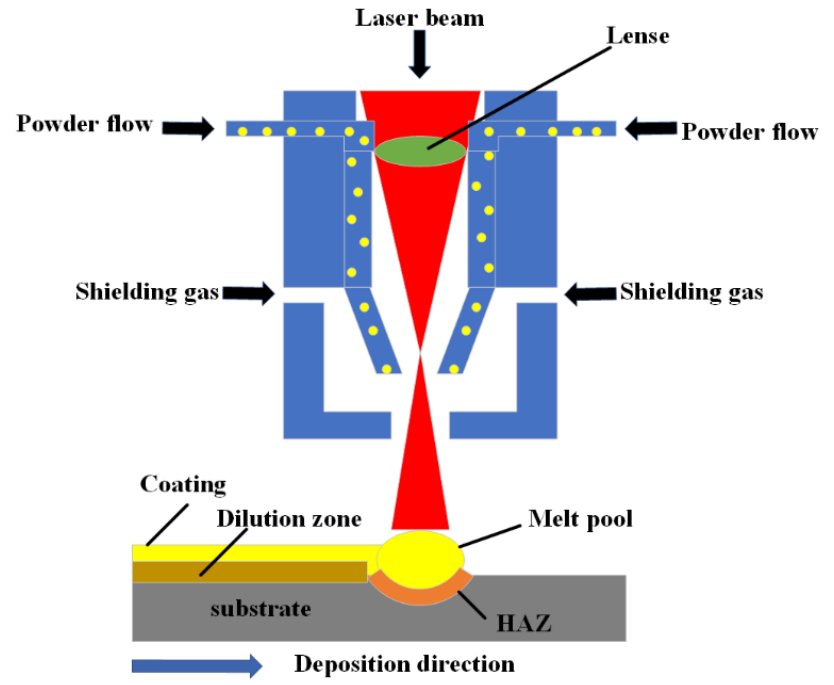
Figure 1. Schematic representation of laser cladding technology.